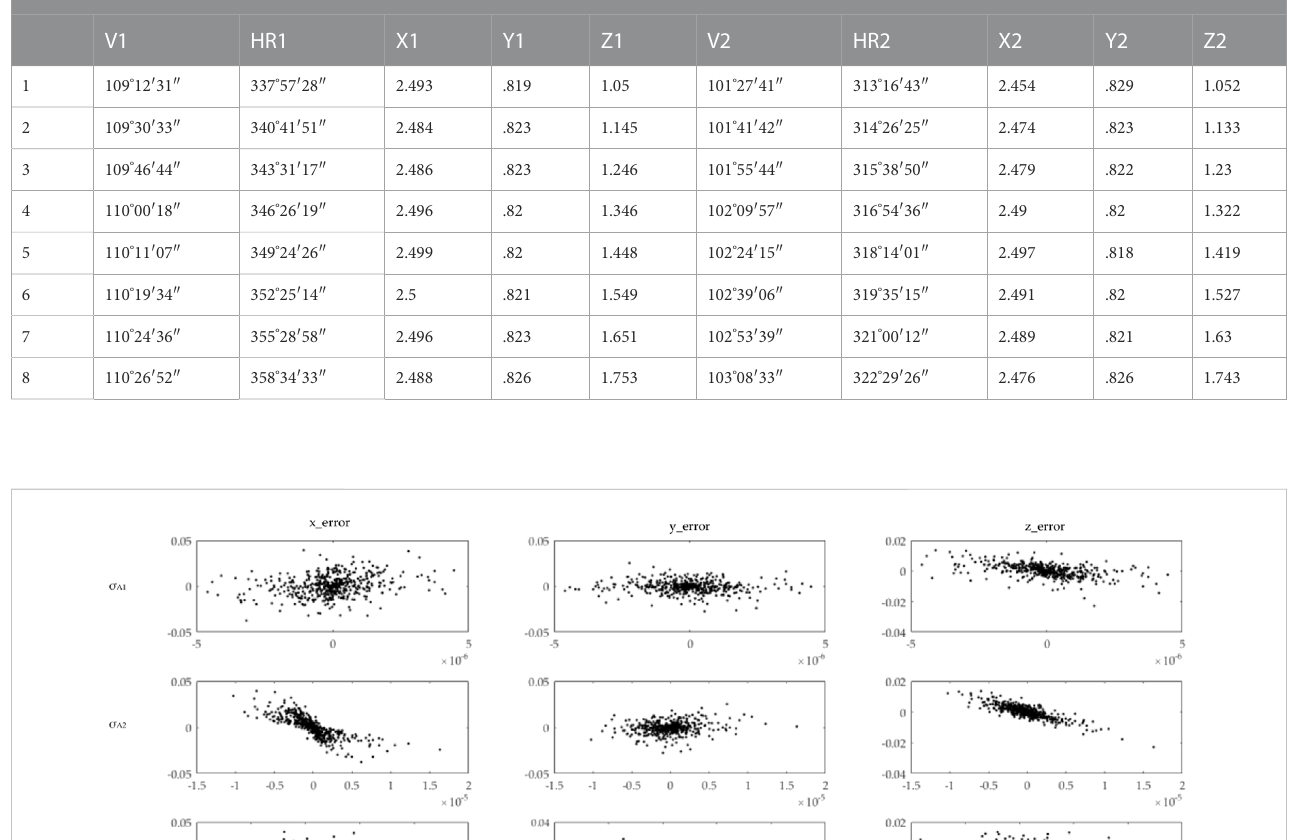
Theodolite 1 and 2 measurement results (unit: m)